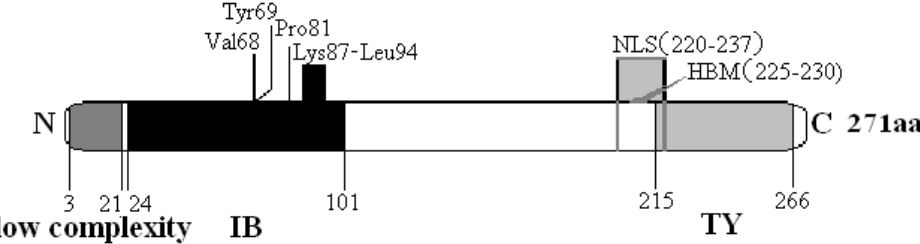
Figure 2. The predicted domain of goat IGFBP-5 protein. IGFBP-5 has a low complexity amino acid starting at 3 to 21. There are two main domains in the IGFBP-5 including an IB domain at amino acid position 24-101 and a TY domain at position 215-266. The domains were predicted using SMART Software (http://smart.embl.de/). The primary binding site for IGF in the N terminus of IGFBP-5 has been mapped to ten clustered residues, Val68, Tyr69, Pro81, Lys87-Leu94, and form a hydrophobic patch on the surface of the protein. The amino acids in 220-237 form the NLS, containing an HBM at amino acid 225 to